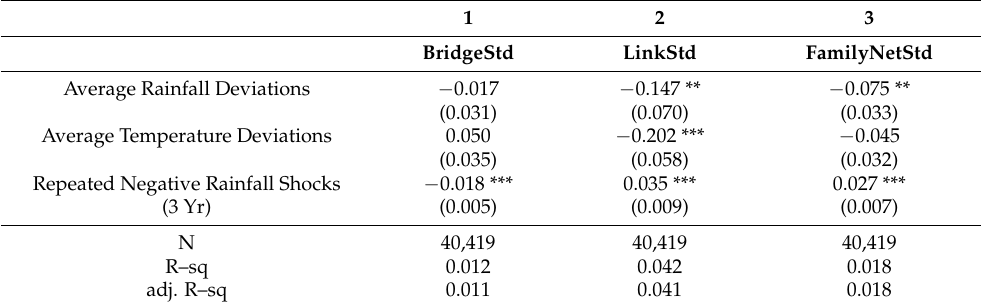
Table 3. Results assessing the impacts of lagged and repeated rainfall shocks on key measures of social